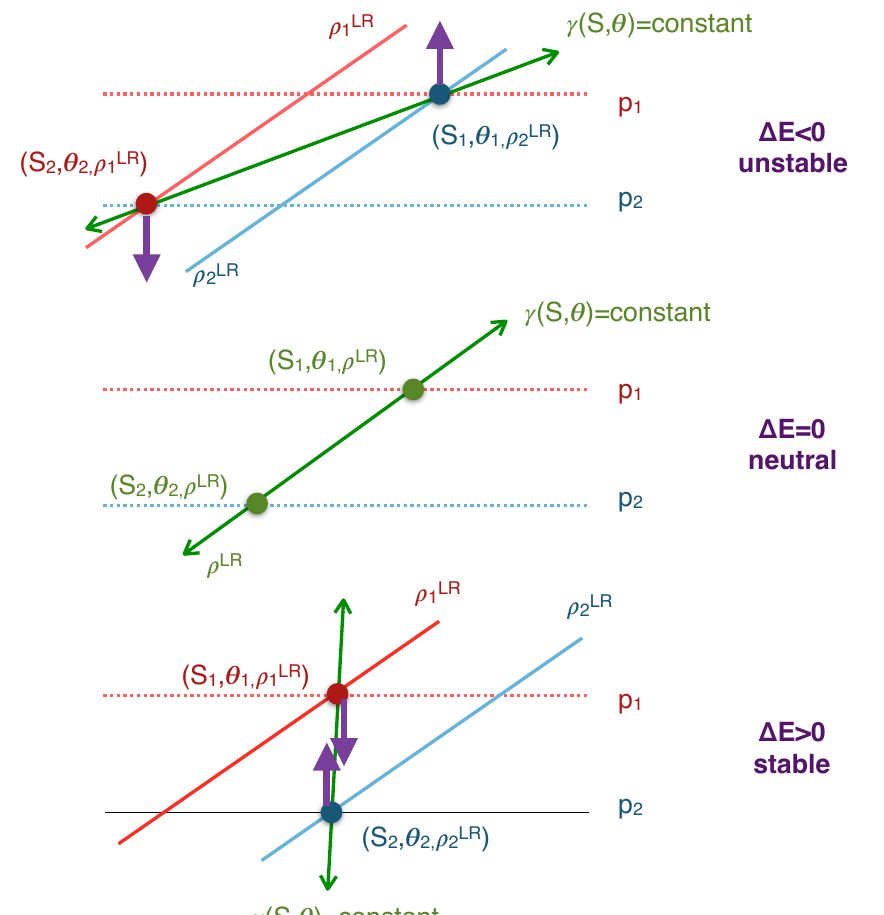
Figure 4. Schematics of the three main physical situations characterising the two-parcels exchange studied in this paper. (Top panel) Spontaneous exchange taking place on a thermodynamic surface going through the “wedge of instability” thus releasing available potential energy. Following the exchange, the fluid parcels become statically unstable and attracted back to their original neutral surfaces; as they do so, they move further apart from each other, causing enhanced lateral dispersion, while also possibly undergoing some irreversible diffusive mixing through entraining some of the surrounding fluid in the process (not considered in this paper). (Middle panel) Energy neutral parcels exchange associated with regular lateral dispersion. (Bottom panel) Forced exchange on a non-neutral thermodynamic surface not going through the wedge of instability thus requiring an external energy input. Following the exchange, parcels are attracted back to their original surfaces, with a possible reduction of the distance separating them, thus with no or little lateral dispersion, while also possibly undergoing some irreversible diffusive mixing as in the unstable case (not considered in this